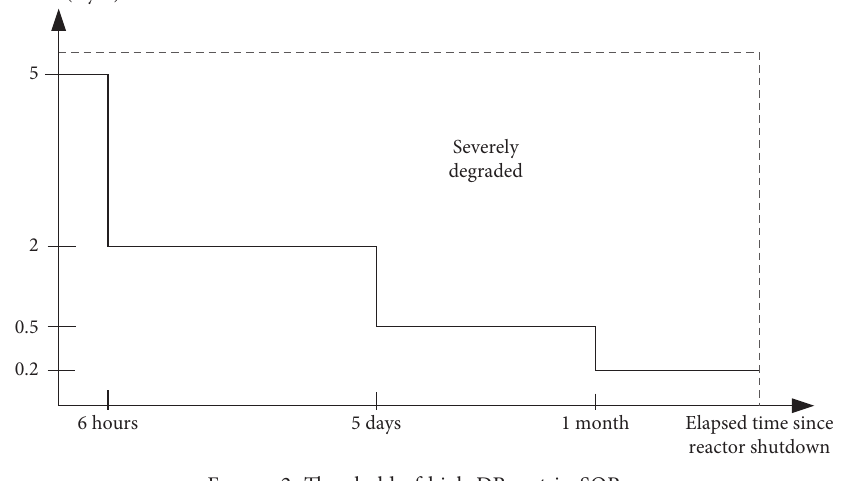
Figure 2: Threshold of high DRcont in SOP.